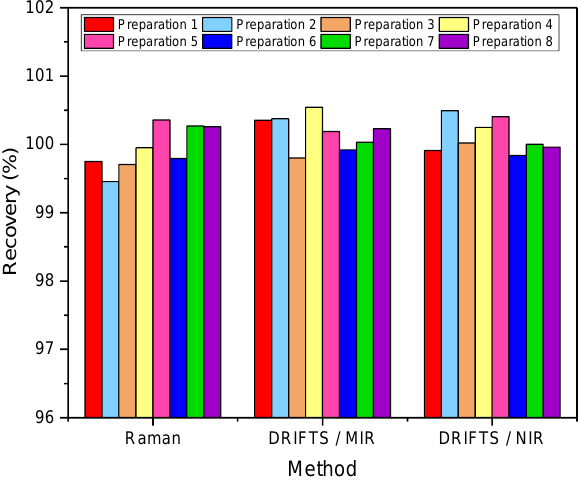
Figure 5. Diosmin recovery ( n = 10).